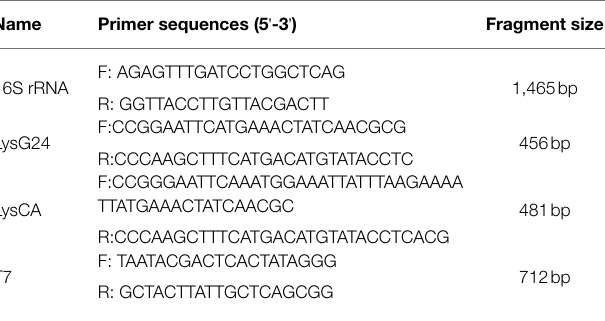
TABLE 1 | Sequences of primers used in the